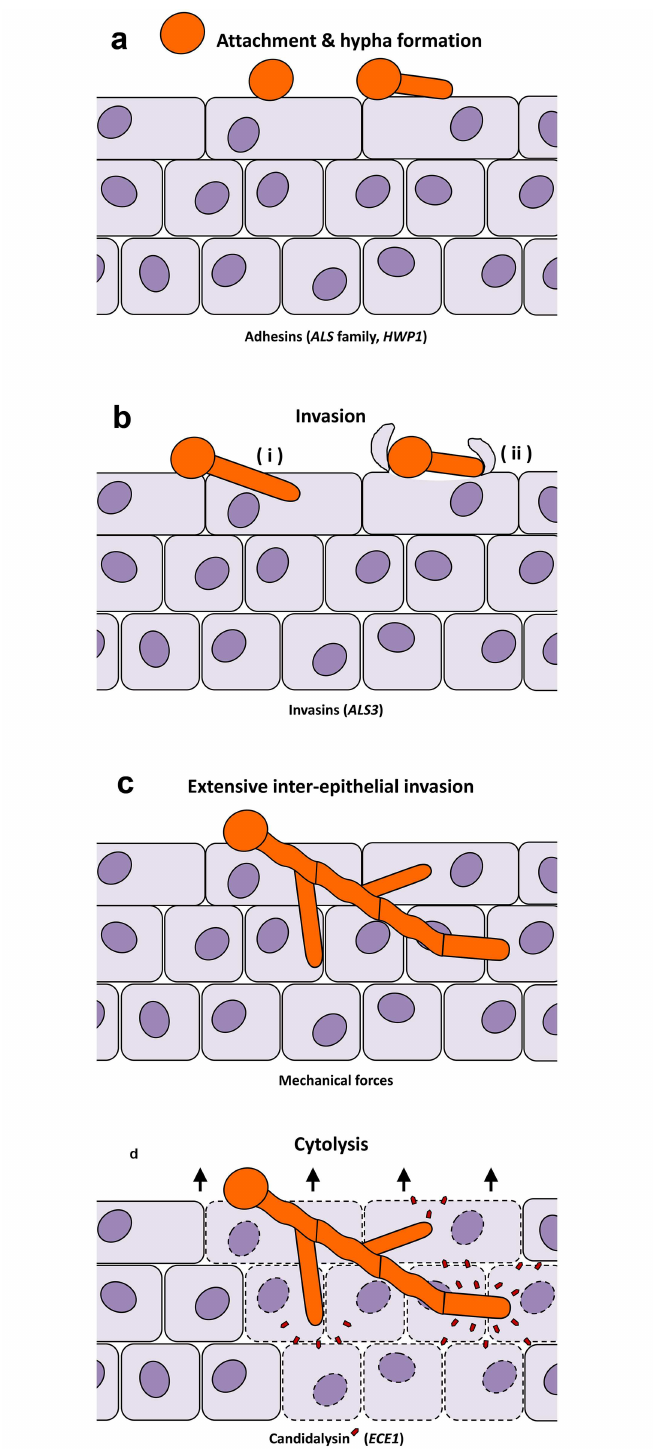
Fig 1. Distinct stages of C . albicans -epithelial infection. ( a ) In experimental epithelialinfections, C . albicans yeasts form hyphae upon contact with epitheliaand adhere tightly to the host cells. This is mediated by a number of adhesins, includingmembers of the Als family and Hwp1. ( b ) This is followedby initial epithelialinvasionvia two routes—(i) fungal-driven active penetrationand (ii) host-mediated induced endocytosis. ( c ) Elongating and branching hyphaeresult in extensive interepithelial invasion. Surprisingly,